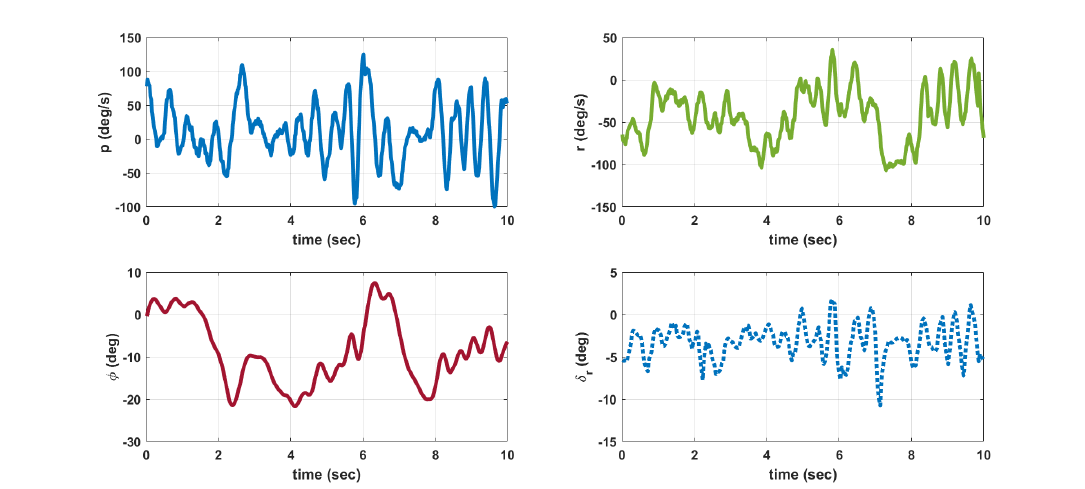
Figure 14. Outputs ( p , r , φ ) and input ( δ r ) for lateral control.